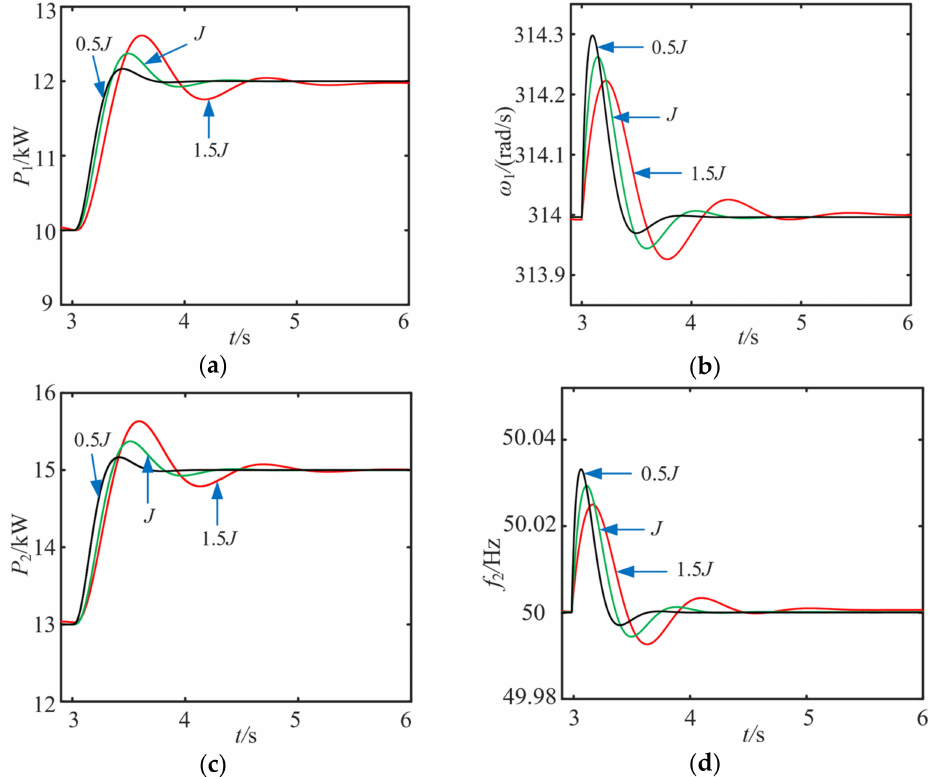
Figure 14. Simulation waveforms with different virtual inertias: ( a ) active power of VSG1; ( b ) virtual angular frequency of VSG1; ( c ) active power of VSG2; ( d ) frequency of VSG2.